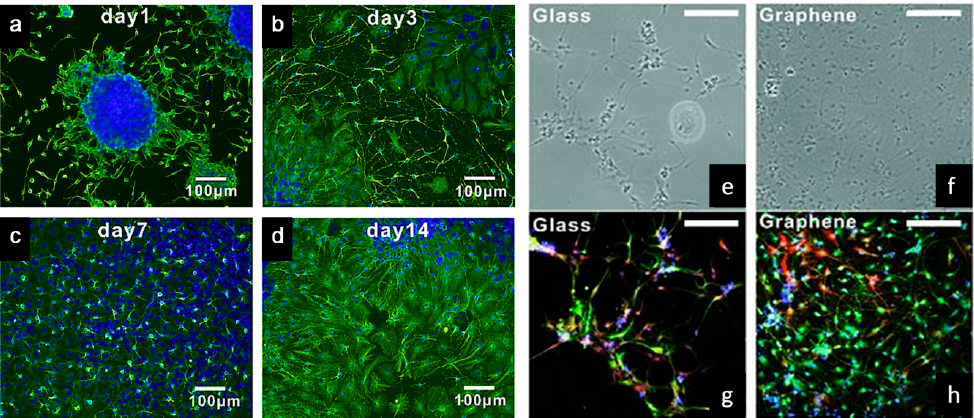
Figure 5. ( a – d ) Immunostaining (B-tubulin) of hNSCs differentiation developing neural networks on graphene substrates [104]. ( e , f ) Bright-field and ( g , h ) fluorescence microscopy images of immunostained differentiated hNSCs on glass and graphene substrates, after one month of cell culture. DAPI (blue) for nuclei, TUJ1 (green) for neural cells and GFAP (red) for astroglial cells [105]. Reproduced with permission from Tang et al., Biomaterials , published by Elsevier, 2013; and Park et al., Advanced Materials , published by Wiley-VCH, 2011.